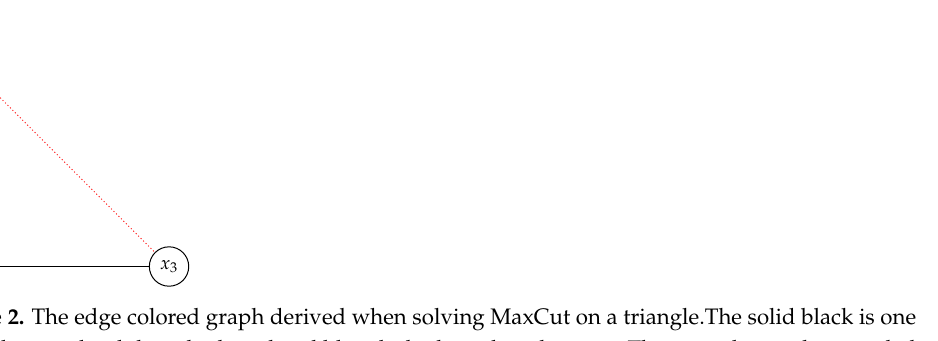
is 1 , x 3 x 2 | (cid:105)